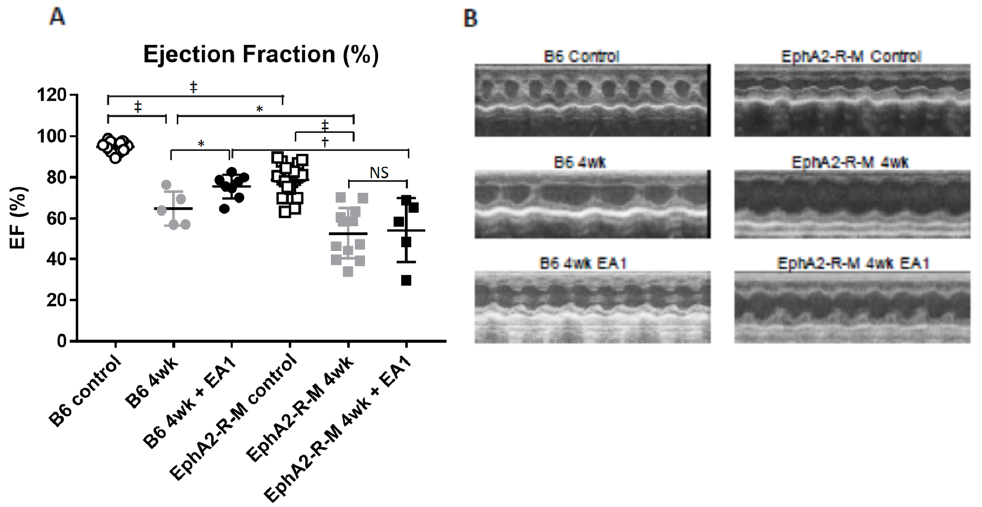
Figure 5. Cardiac Function in WT B6 and EphA2-R-M Mouse Hearts. EF ( A ) improved 10.7% from untreated to ephrinA1-Fc- treated B6 mice, but there was no statistically significant difference between treated and untreated EphA2 mice (* p < 0.05, † p < 0.01, ‡ p < 0.001). B6 WT control ( n = 11), EphA2-R-M control ( n = 22), WT B6 (IgG-Fc 4w, n = 12), EphA2-R-M (IgG-Fc, n = 13), EA1-treated WT B6 ( n = 11) and ephrinA1-Fc-treated EphA2-R-M ( n = 4). ( B ) Representative traces for all WT and EphA2-R-M groups. 2.6. Immunohistochemical Detection of α-SMA + Myofibroblasts in Infarcted Mouse Heart Representative immunohistochemical images (Figure 6) of smooth muscle α-actin positive cells in uninjured B6 and EphA2 control heart tissue demonstrate expected staining of vascular smooth muscle cells (VSMCs) in large vessels. At 4 weeks post-MI, SMα-A positive myofibroblasts are visible in the infarcted myocardium in both B6 and EphA2, but to a much lesser extent in ephrinA1-Fc- treated B6 and EphA2-R-M mice ( n = 3/group). Figure 6. Active Myofibroblasts in Infarcted WT B6 ( A – C ) and EphA2-R-M ( D – F ) Mouse Hearts. Smooth muscle α-actin positive cells in uninjured B6 and EphA2 control heart tissue demonstrate expected staining of VSMCs in large vessels (200×). At 4 weeks post-MI, SMα-A positive myofibroblasts are visible in the infarcted myocardium in both B6 and EphA2, but to a much lesser extent in ephrinA1- Fc-treated B6 and EphA2-R-M mice ( n = 3/group).